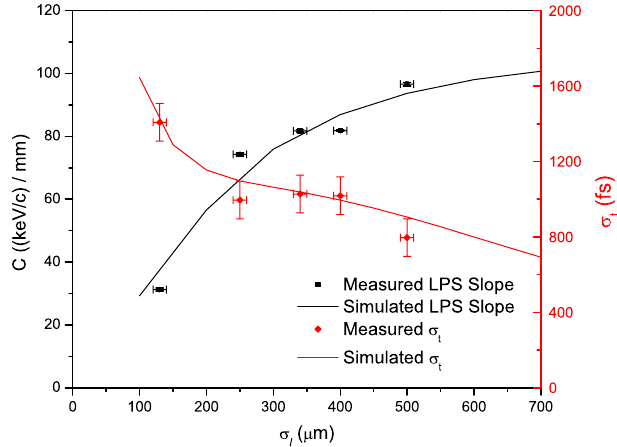
6. (Color) A scan of the chirp ( C ) (left axis, black) and (cid:8) t (right axis, red) versus beam charge. The measured values (points) are compared to simulations performed with general particle tracer (lines). The scan was performed with (cid:11) degrees and an initial spot size at the cathode, (cid:8) l ¼ 500 (cid:1) m .